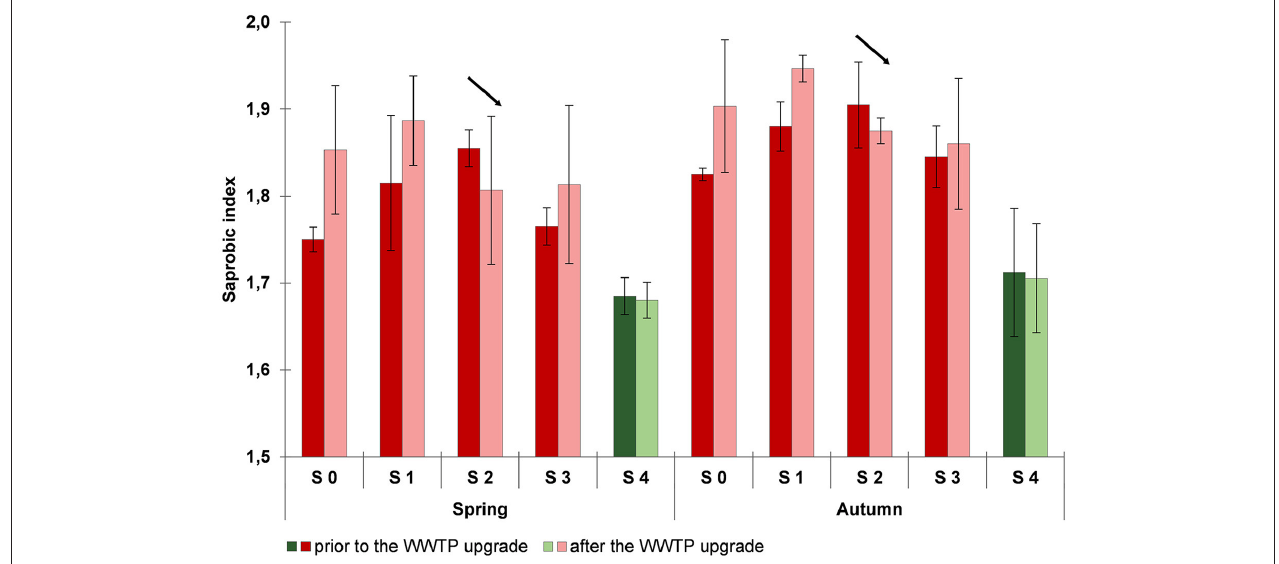
FIGURE 8 | Saprobic index in spring and autumn prior to (2012 and 2013, dark colors) and after (2014, 2015, and 2016; light colors) the wastewater treatment plant (WWTP) upgrade. Data are shown as arithmetic means and standard deviations. Data for the sampling sites at the Schussen river are shown in red colors: S 0 upstream of the WWTP and upstream of the stormwater overflow basin (SOB) Mariatal, S 1 upstream of the WWTP and downstream of the SOB, S 2 directly downstream of the WWTP, S 3 15km downstream of the WWTP; data for the sampling site S 4 at the Argen river are shown in green